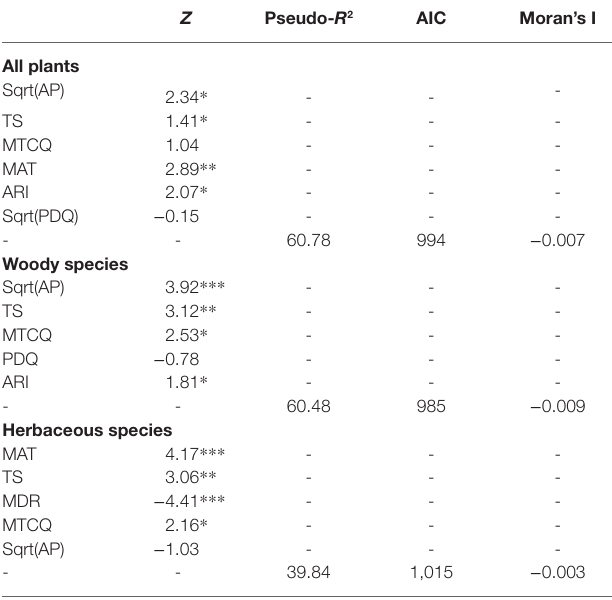
TABLE 2 | Results of simultaneous autoregressive error (SAR) models for all environmental variables and the proportion of total, woody, and herbaceous samara species to total